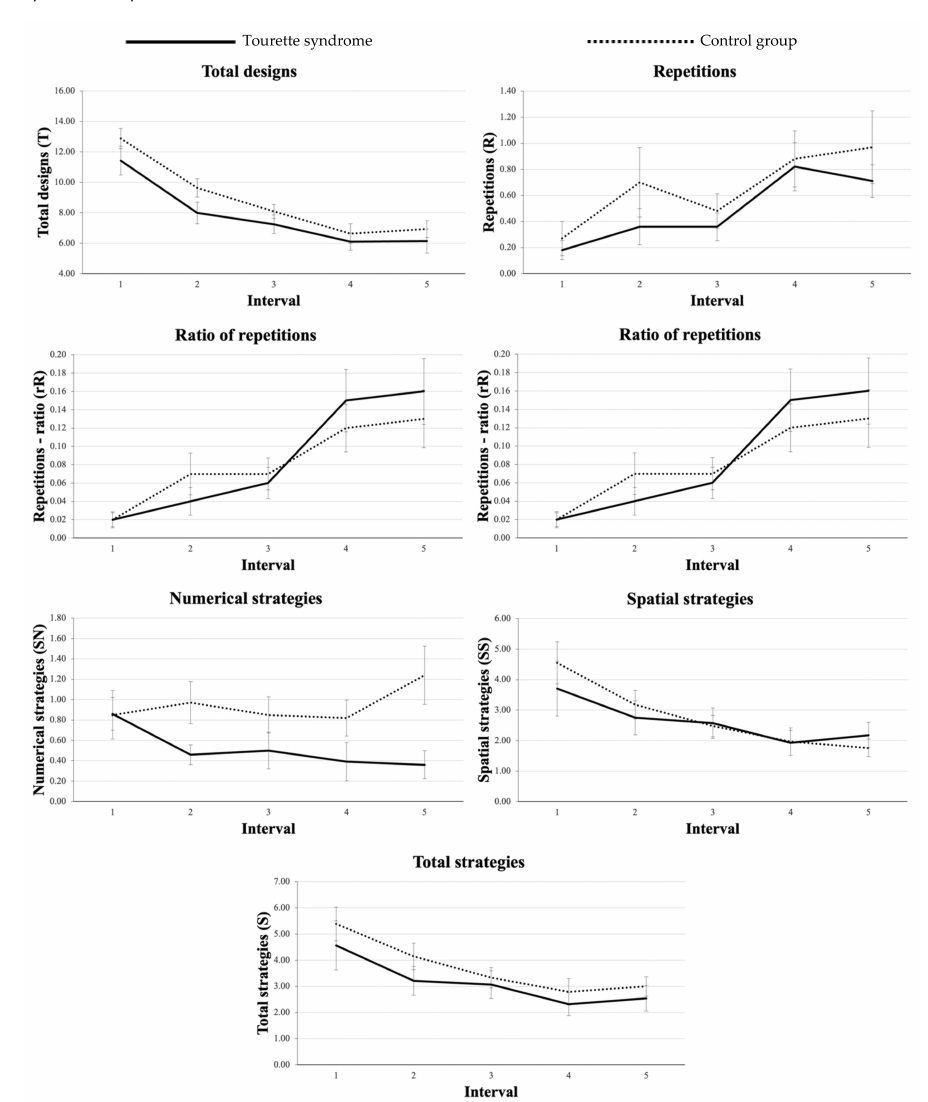
Figure 2. Averages of DF scores in function of intervals for Total designs, Unique designs, Repetitions, Repetition ratio, Numerical strategies, Spatial strategies, and Total strategies for each one-minute FPT interval. Error bars represent the standard error of the